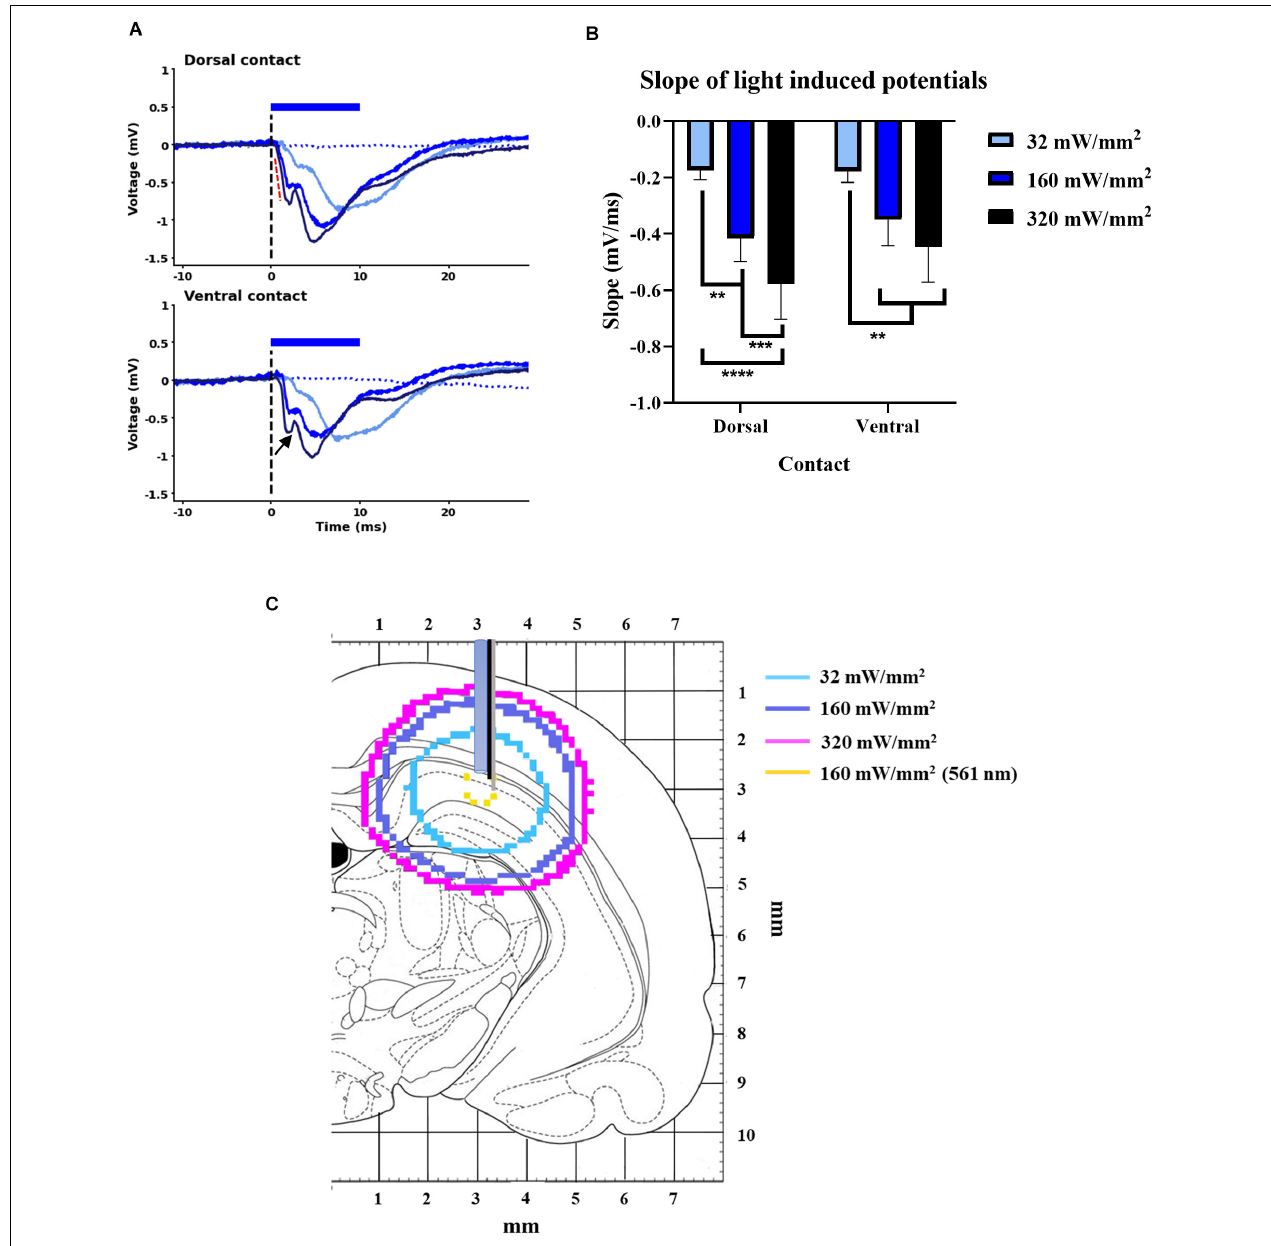
FIGURE 1 | Light-induced potentials from GtACR2 expressing CA1 subfield. (A) A negative field potential with compound morphology (black arrowhead) at dorsal and ventral contacts of optrode for the three light-power densities. Black dotted line indicates time of light delivery; in Sham group, no light-induced potential was detected (blue dotted line, 160 mW/mm 2 ). (B) Slope of light-induced potentials animals (indicated by red dotted line in A ) increased with higher LPD at both dorsal and ventral contacts of the optrode ( n = 8). ** p < 0.005, *** p < 0.0005, and **** p < 0.0001. (C) Fluence contours of 0.05 mW/mm 2 (i.e., EPD50 of GtACR2) for three light-power densities of blue-light (470 nm) and 5.4 mW/mm 2 (i.e., EPD50 of eNpHR3.0) for LPD of 160 mW/mm 2 of yellow-light (561 nm) (Modified from Paxinos and Watson,